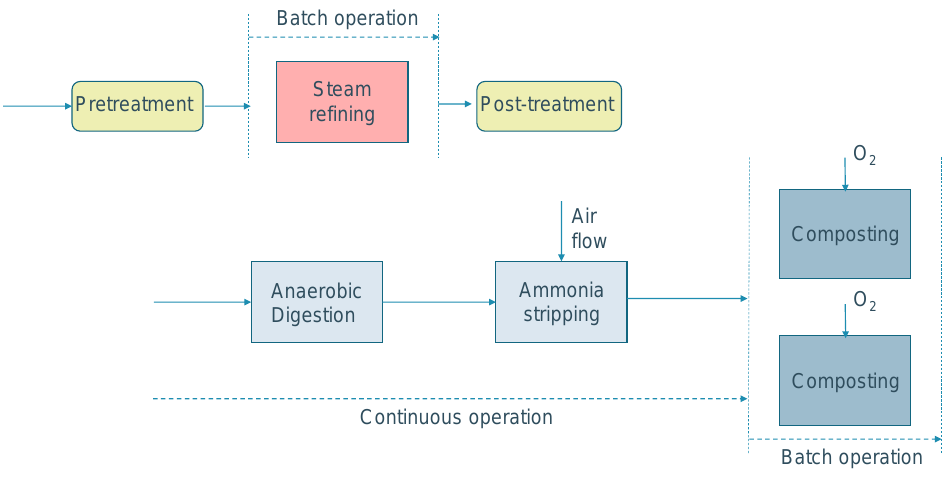
Figure 7. Biorefinery